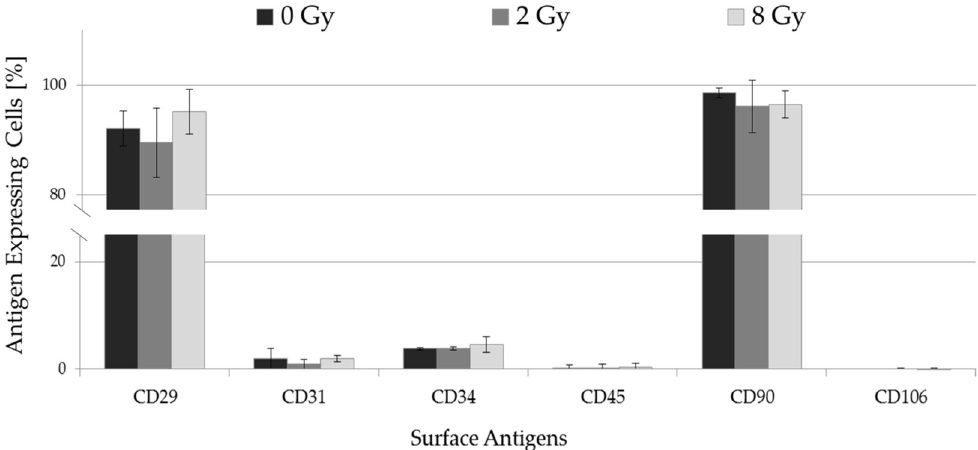
Figure 1. Surface antigen expressions (CD29, CD31, CD34, CD45, CD90, and CD106) of pADSCs 72 h after being irradiated with 2 or 8 Gy. The expression values of isotype-matched control immunoglobulin-labeled cells were deducted from determined expression levels of each surface antigen, and unstained cells were also carried as controls. Data are presented as mean ± standard deviation, n = 3.